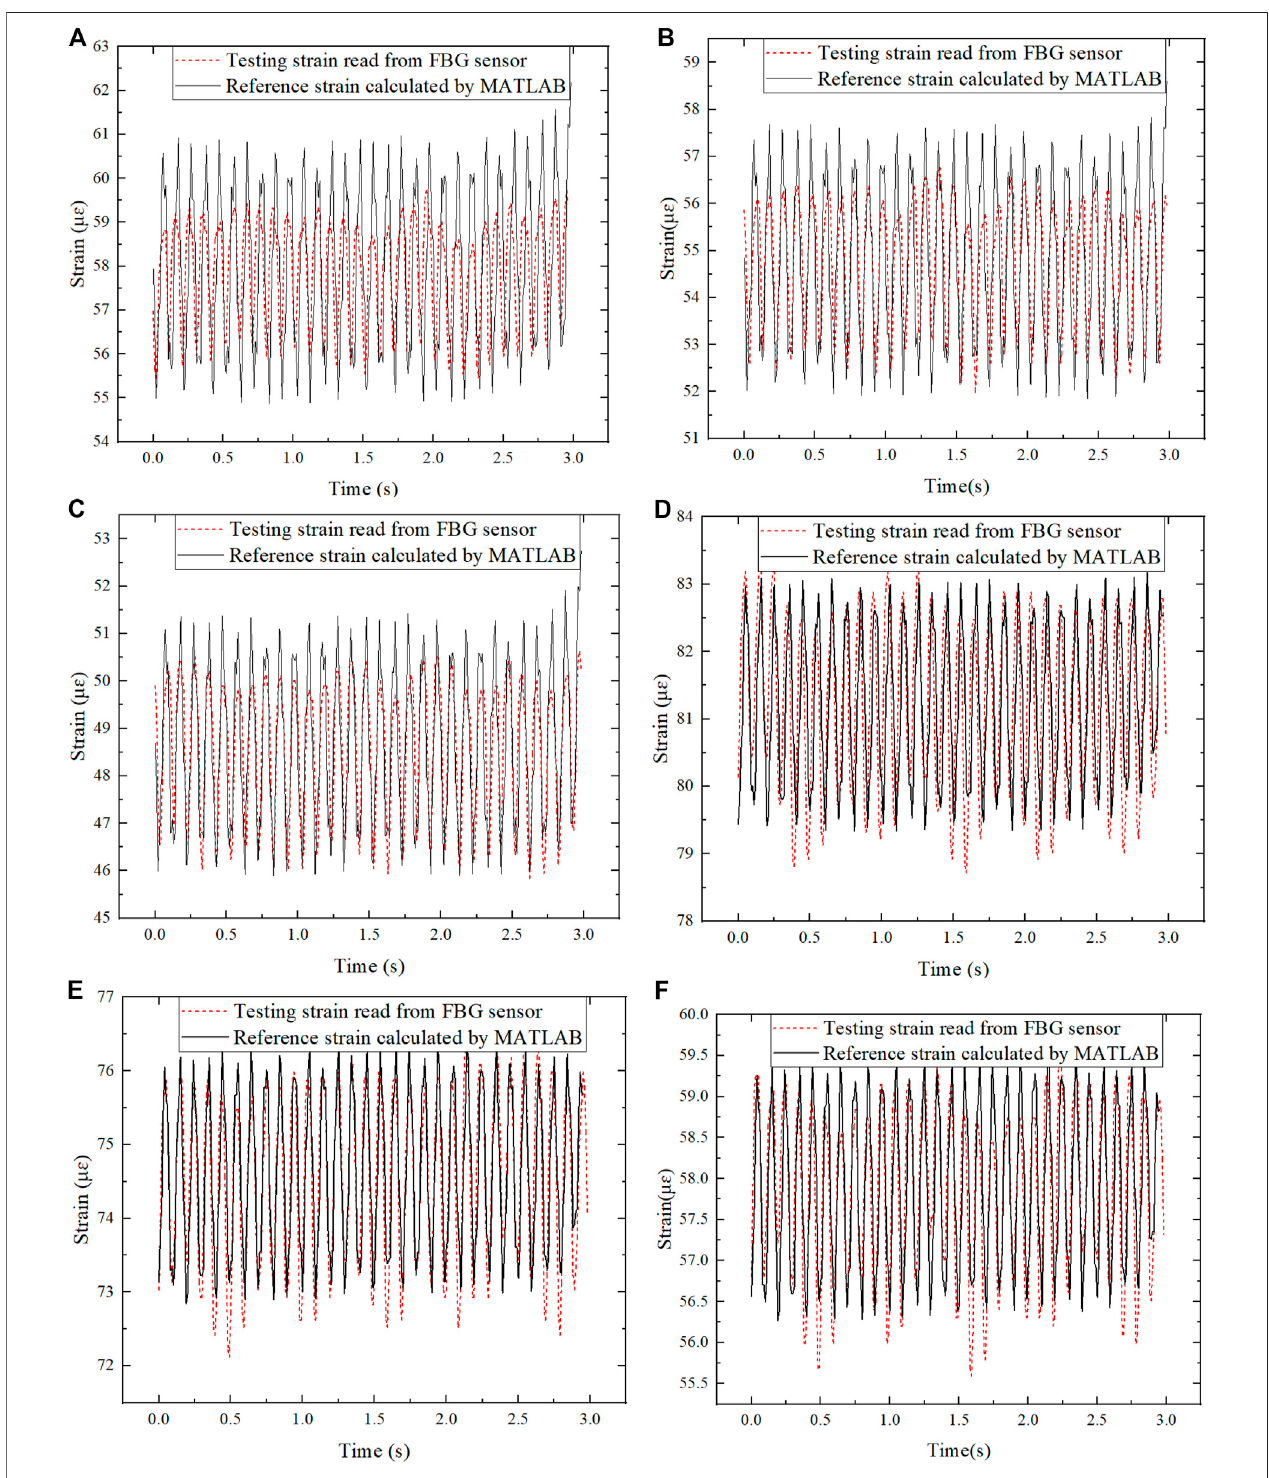
FIGURE13| Comparison ofcalculatedstrain andmeasuredstrain in10 Hz: (A) Bare-FBG2-pipe2; (B) Bare-FBG3-pipe2; (C) Bare-FBG4-pipe2; (D) Bare-FBG5- pipe2; (E) Bare-FBG6-pipe2; (F) Bare-FBG7-pipe2.